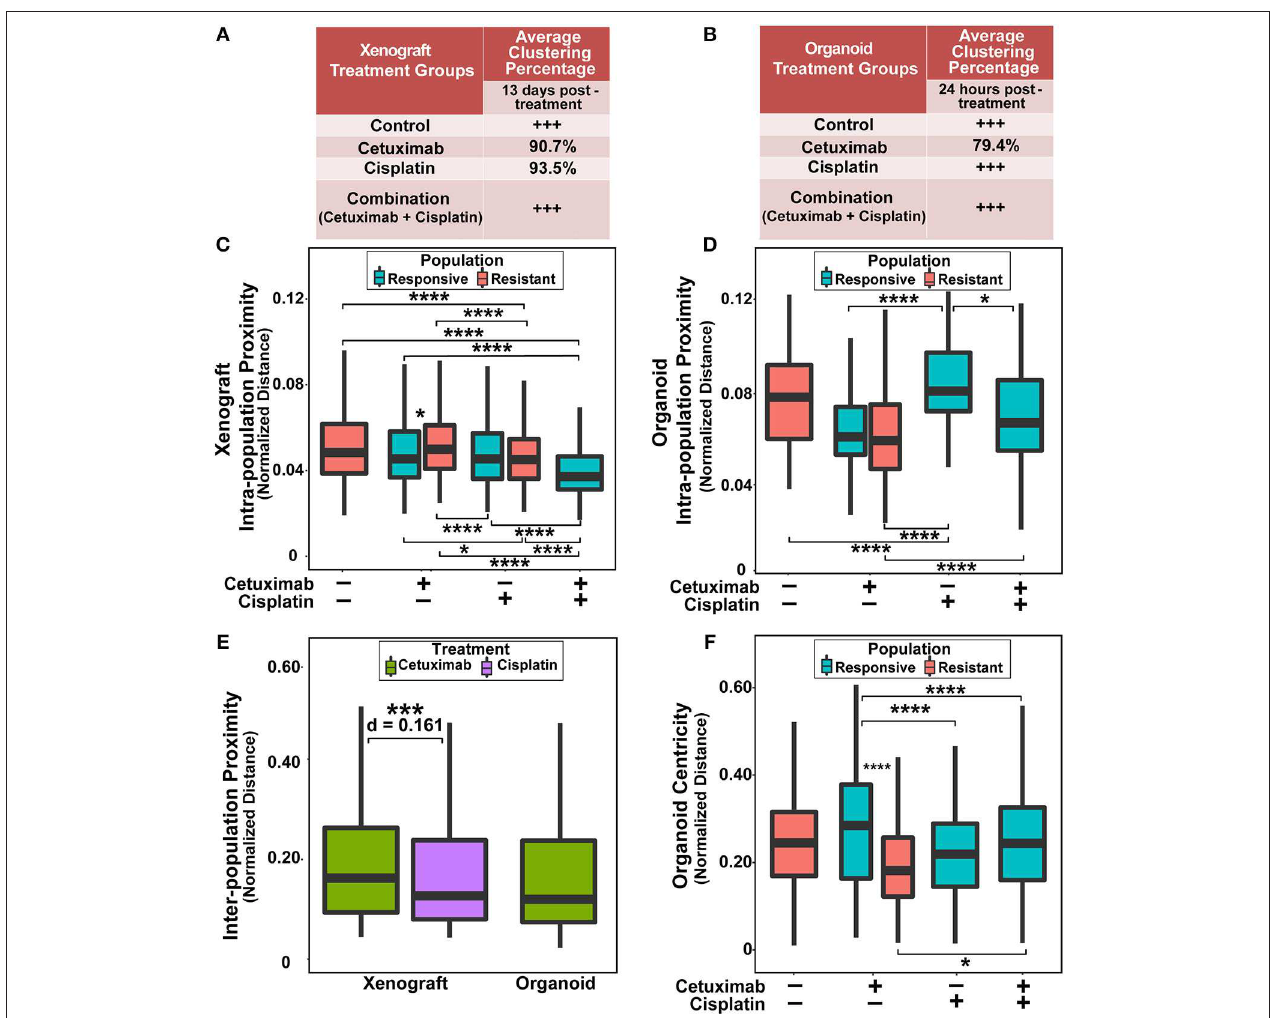
FIGURE 3 | Spatial clustering and proximity based on NAD(P)H τ m for responsive and resistant cell populations. (A) Clustering percentage in xenografts after 13 days of treatment. Control and combination-treated xenografts have only one population of cells each, indicated by + + + . (B) Clustering percentage in organoids after 24h of treatment. Only cetuximab treatment yields multiple cell populations in organoids. (C) Average distance between cells within a single population (intra-population proximity) in xenografts. (D) Intra-population proximity in organoids. (E) Average distance between responsive and resistant cells (inter-population proximity) in xenografts and organoids for treatments that have 2 populations. (F) Average distance to organoid centers (organoid centricity). (*, ***, **** p < 0.05, 0.001, 0.0001; Tukey-HSD